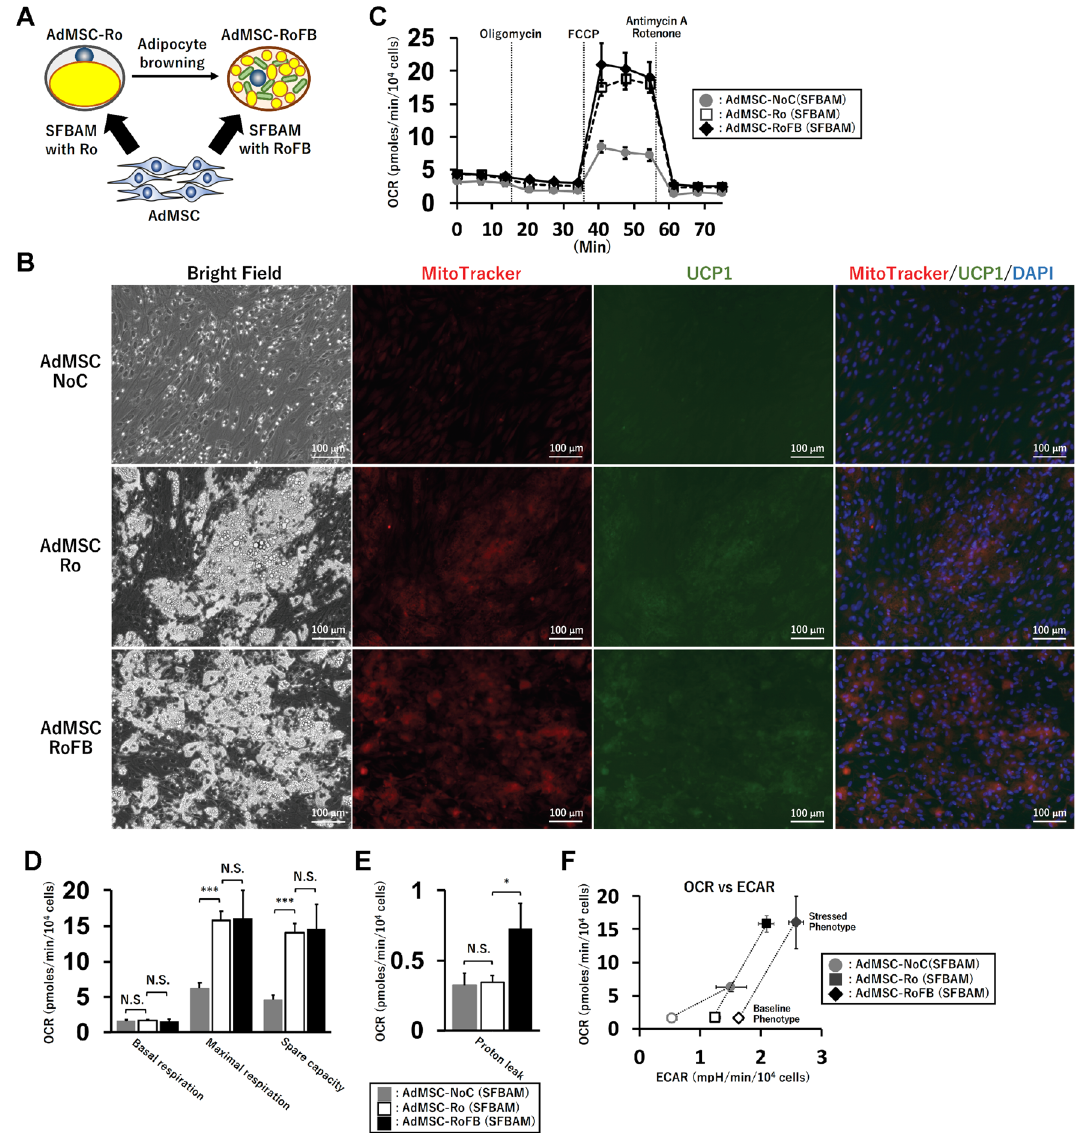
Figure 3. Characterization of AdMSC-derived adipocytes. ( A ) A schematic figure indicates that two types of adipocytes were differentiated from AdMSC by the treatment with either Ro (AdMSC-Ro) or RoFB (AdMSC- RoFB) in SFBAM. ( B ) Representative images of bright field, mitochondrial labelling with MitoTracker (red), UCP1 protein expression (green), and merged image in the control AdMSC (AdMSC-NoC) and the AdMSC- derived adipocytes (AdMSC-Ro and AdMSC-RoFB). The nuclei were visualized by DAPI (blue). Scale bars represent 100 μm. ( C ) Oxygen consumption rate (OCR) was measured using the Flux analyzer in AdMSC- NoC (grey circles), AdMSC-Ro (open squares), and AdMSC-RoFB (black diamonds). Oligomycin, FCCP, and Antimycin A/Rotenone were added during the measurement as indicated. ( D , E ) Each OCR corresponding to basal respiration, maximal respiration, and spare capacity ( D ), and proton leak ( E ) was calculated. ( F ) Energy phenotype profile in AdMSC-NoC (grey circles), AdMSC-Ro (open squares), and AdMSC-RoFB (black diamonds). OCR and extracellular acidification rate (ECAR) were plotted under basal (open circle, square, and diamond) and stressed (closed circle, square, and diamond) conditions. The stressed condition was caused by the treatment with both Oligomycin and FCCP. Data represent mean ± SEM (n = 6). Student’s t-test: *P < 0.05, ***P < 0.001, N.S. not